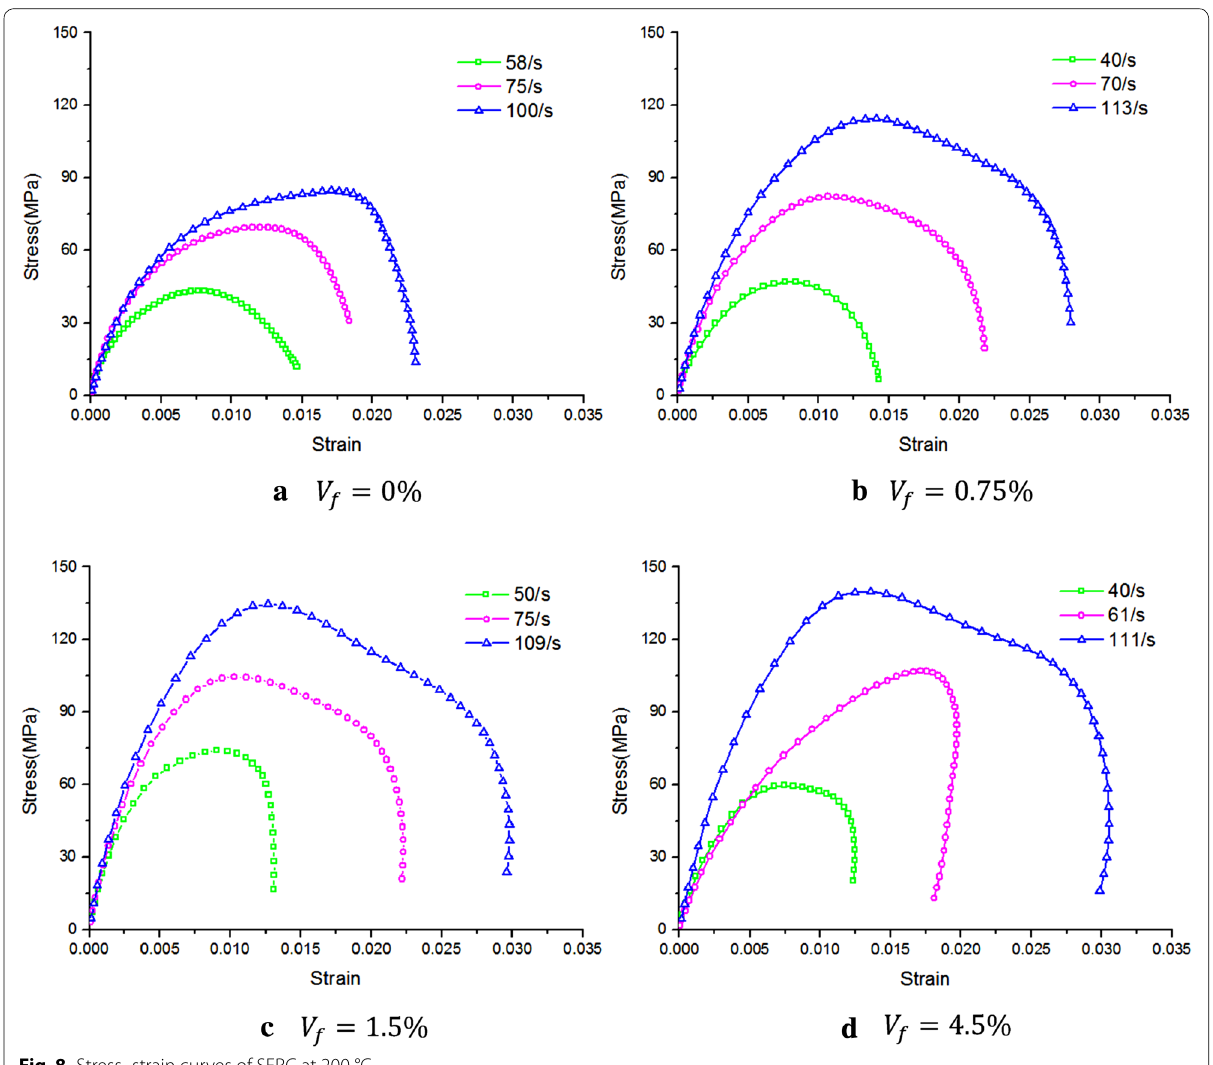
Fig. 8 Stress–strain curves of SFRC at 200